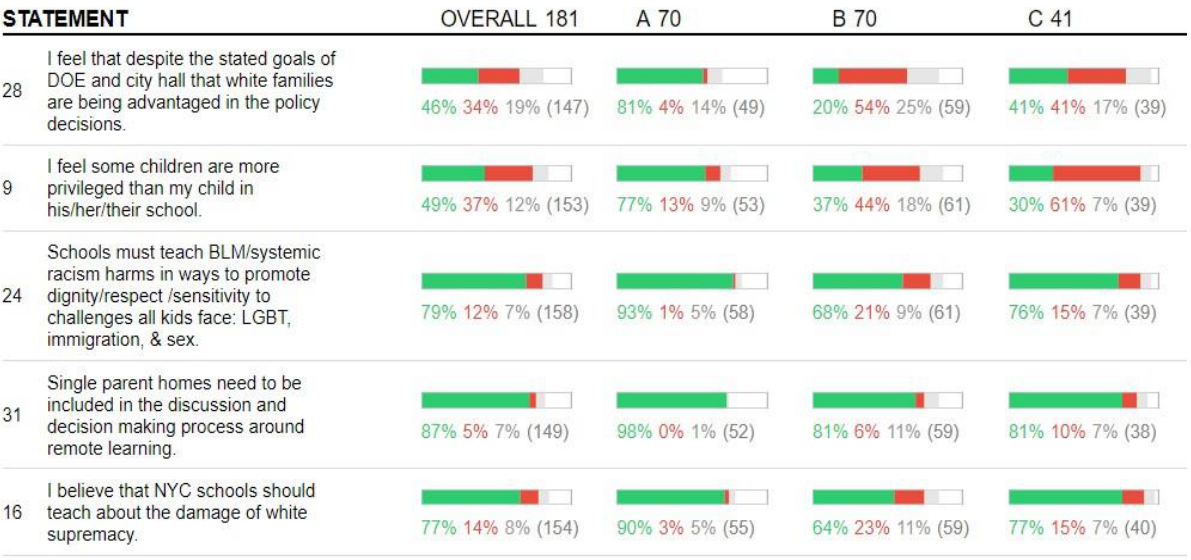
Figure 1. Pol.is Survey Results